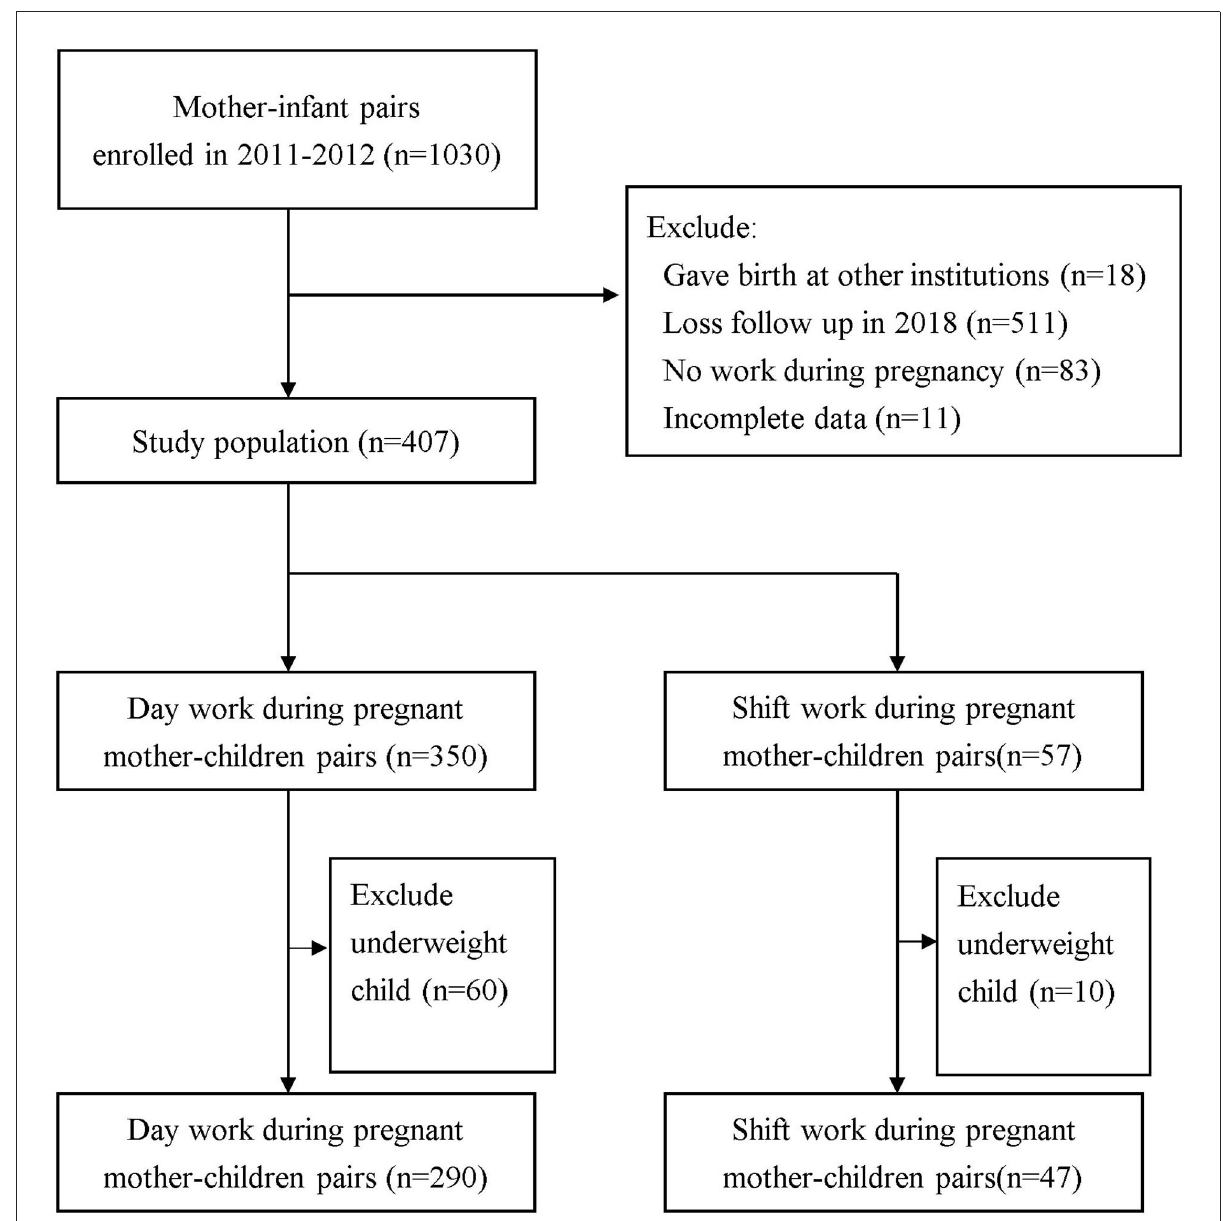
FIGURE1 Flowchart of study population selection.